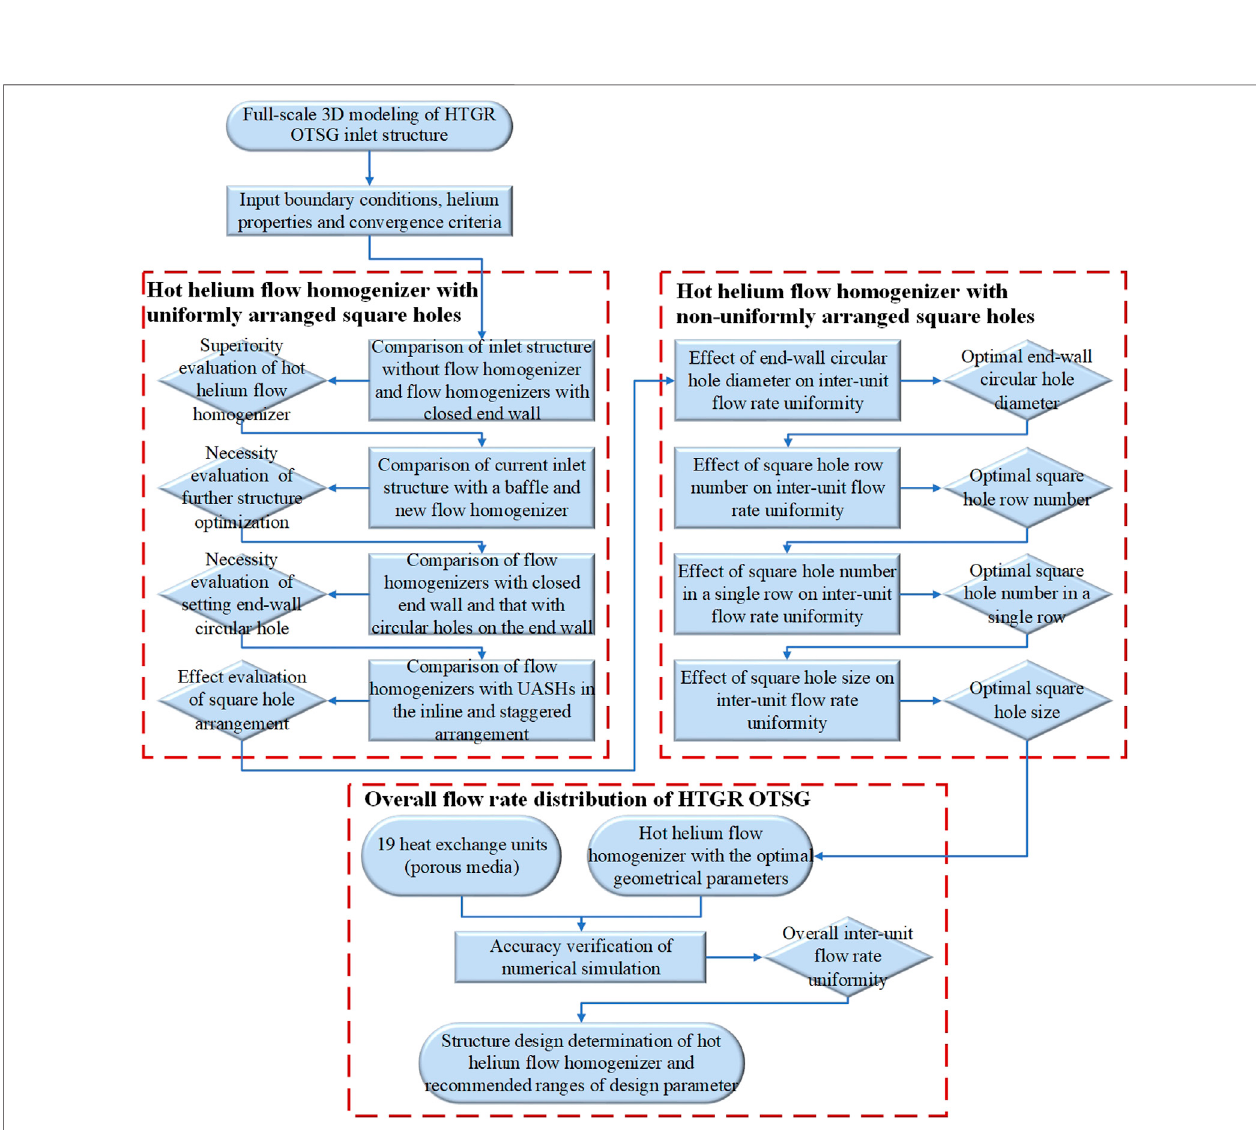
FIGURE 3 | Flow chart of the